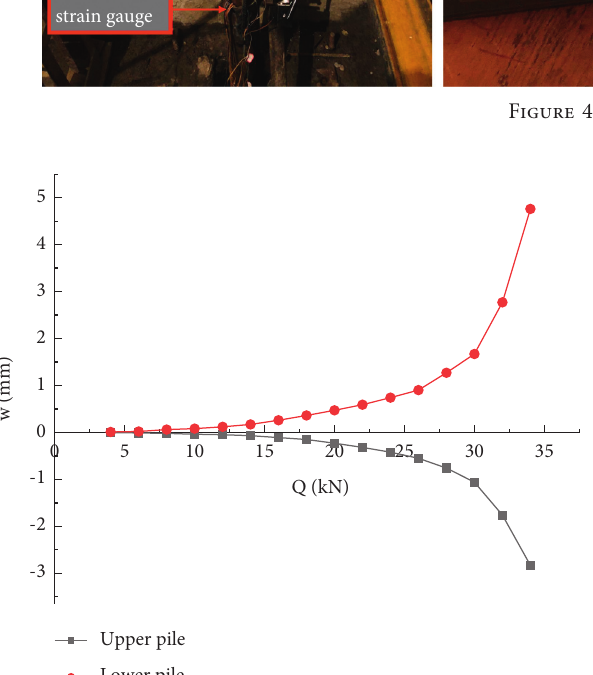
instrumentPressure indicator static strain data collection